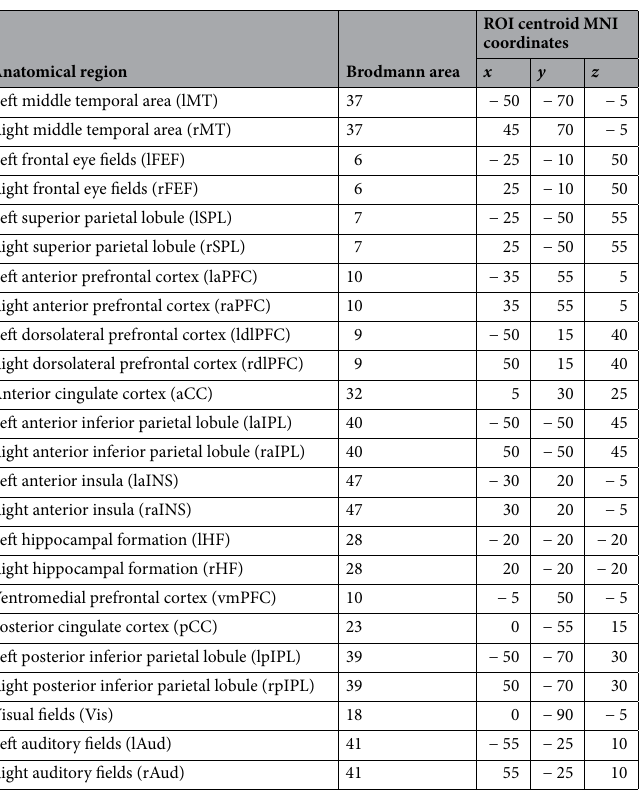
Table 3. The 24 cerebral regions of interest determined by eLORETA. ROI region of